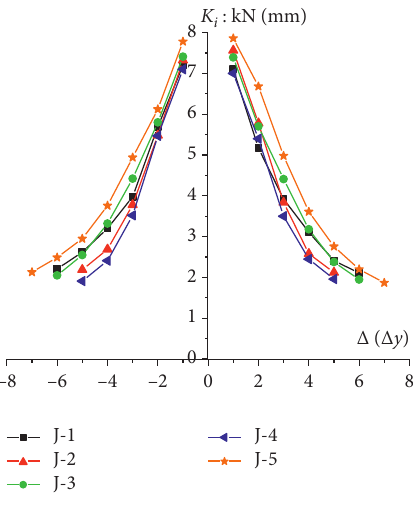
Figure 14: Stiffness